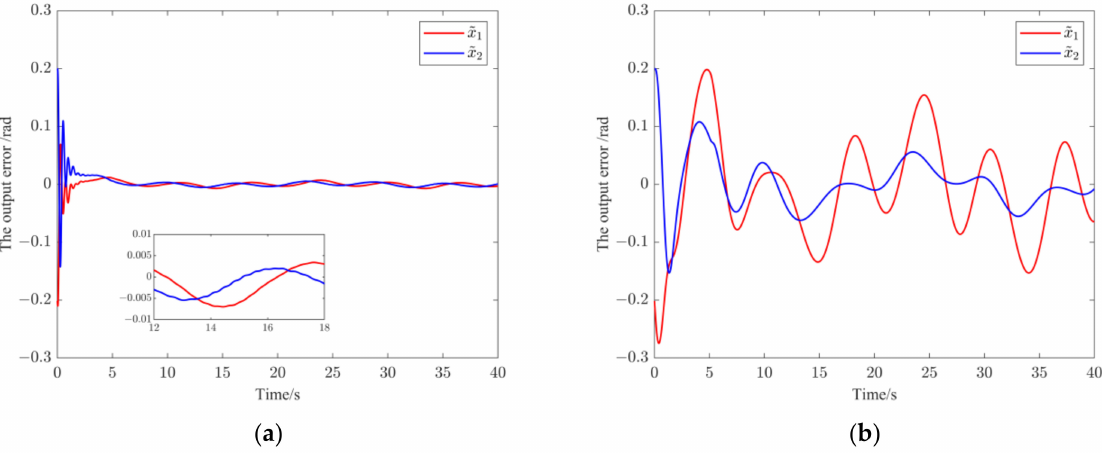
Figure 21. The output error (cid:101) x . ( a ) RBFTHC, ( b ) CTC.